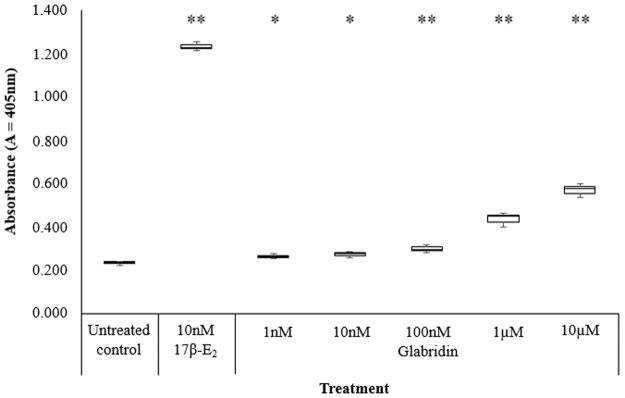
Effect of varying concentrations of glabridin on ALP activity in Ishikawa cells in comparison to the untreated control and 1nM 17β-E2.The values represent the mean activity of three treatment group. *P<0.05 and ** P≤0.01 against the untreated control.